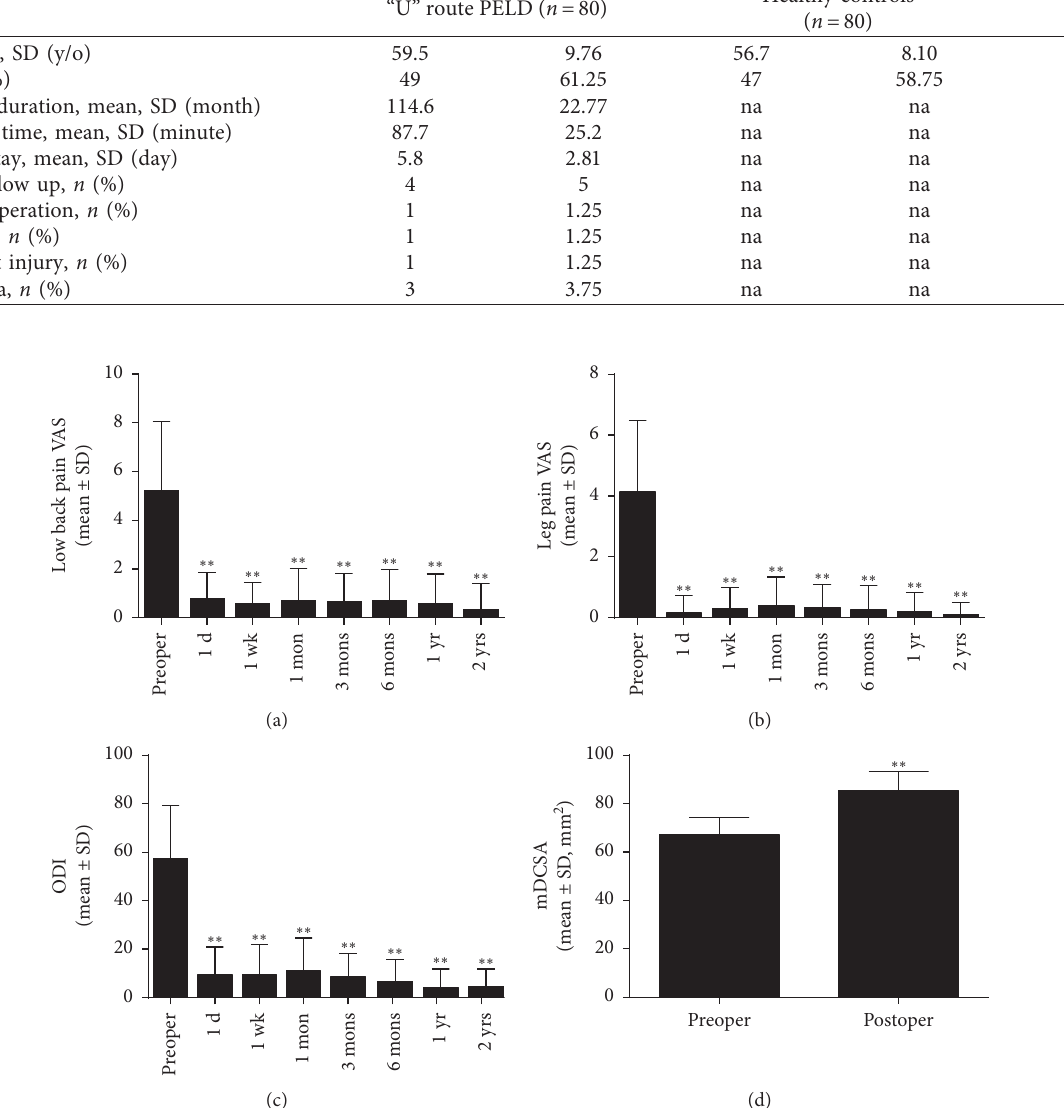
Figure 4: (a, b)VAS scores of the low back and leg pain, (c) ODI, and (d) mDCSA before and after the “U” route PELD surgery. VAS scores show the low back and leg pain rating and decrease at all postoperative time points compared with that preoperatively ( p < 0 . 01). The postoperative mDCSA measured 3 months after surgery is significantly improved compared with preoperation. ∗ p < 0 . 01, compared with